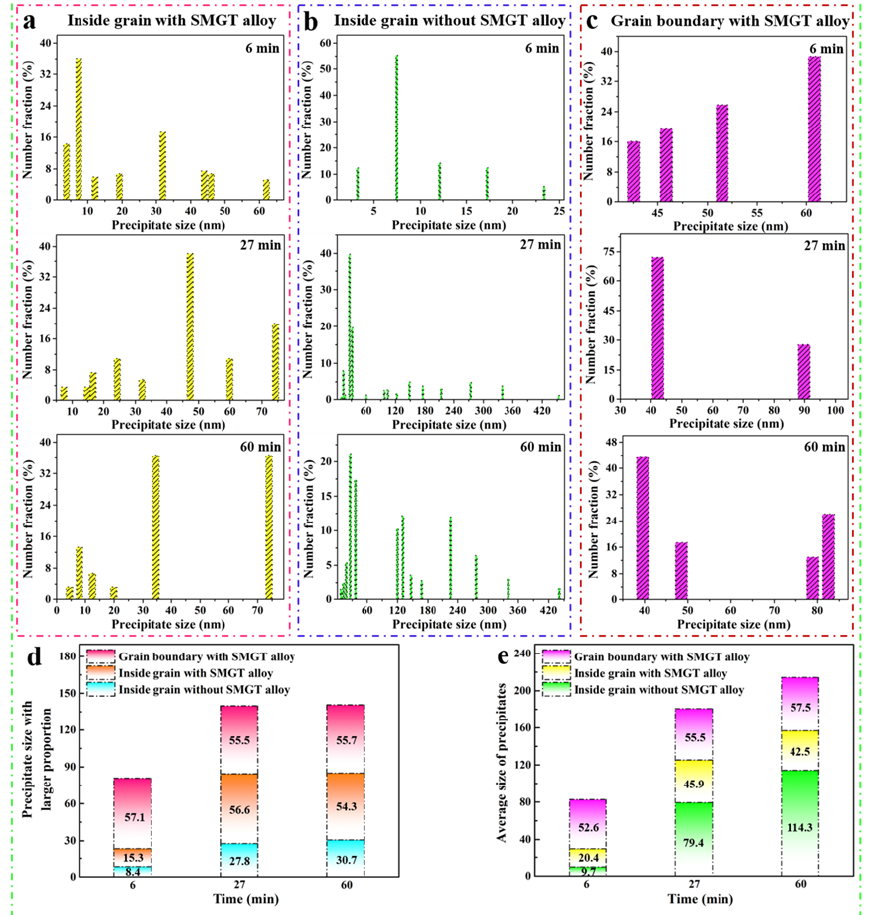
Figure 9. The statistical distribution of precipitate size at 210 ◦ C for different aging times: ( a ) inside grain with SMGT alloy; ( b ) inside grain without SMGT alloy; ( c ) grain boundary with SMGT alloy; ( d ) precipitate size with a larger proportion; ( e ) average size of precipitates with